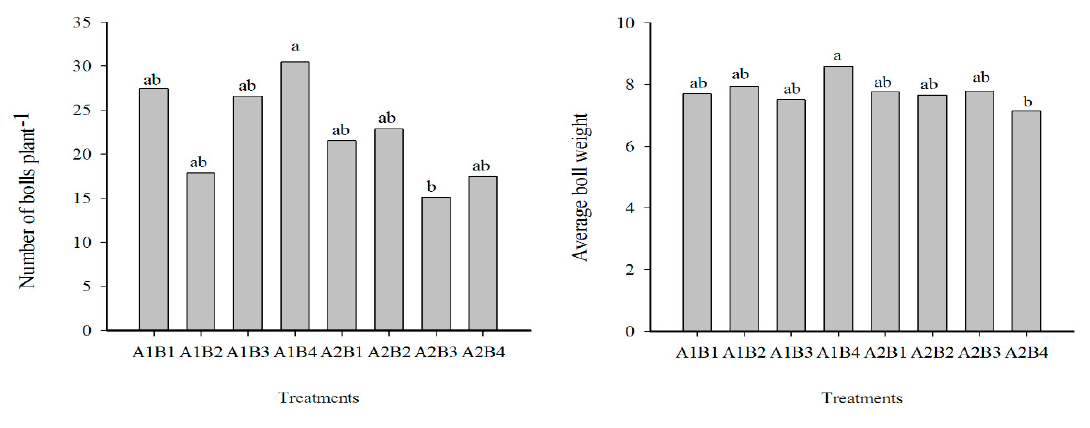
Figure 1. Effects of nitrogen, phosphorous, and potassium application ratio on the number of bolls plant − 1 and average boll weight (g) of two cotton cultivars Siza 1 and Sikang 1 DAF during 2016. Different letters on the bars in the figure indicate there was a significant difference at the 0.05 probability level by an ANOVA-protected test.